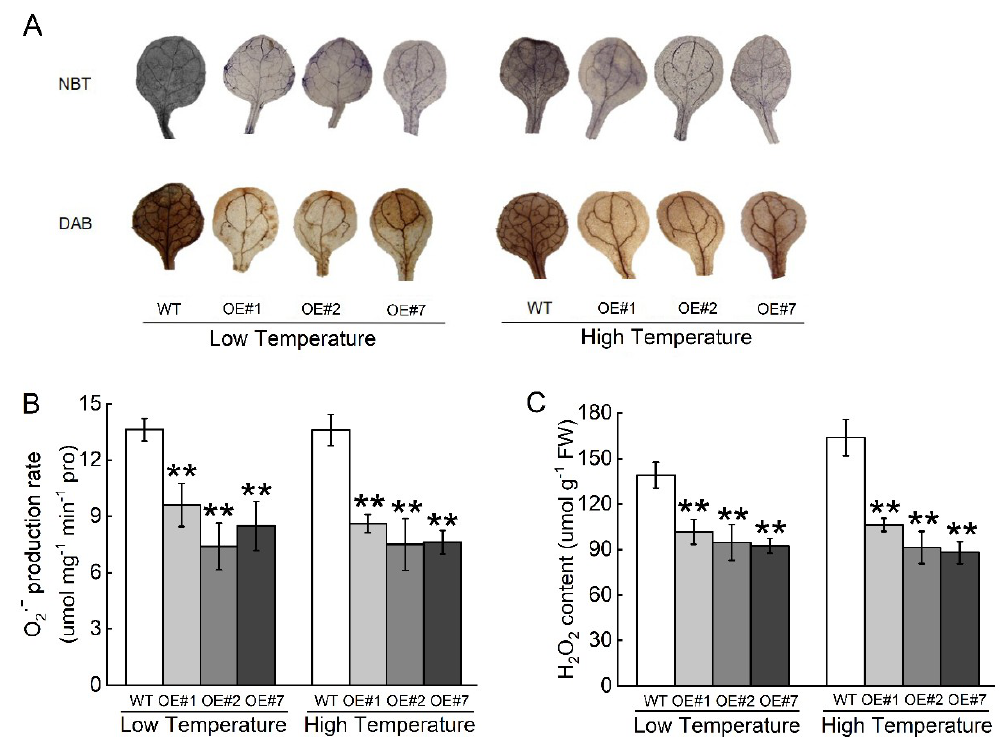
Figure 9. Oxidative damage of WT and OE lines of Arabidopsis plants. ( A ) Histochemical staining assay for superoxide anion (O 2 •− ) by nitro blue tetrazolium (NBT) and hydrogen peroxide (H 2 O 2 ) in the upper row and by 3,3-diaminobenzidine (DAB) staining in the lower row. ( B ) Quantification of O 2